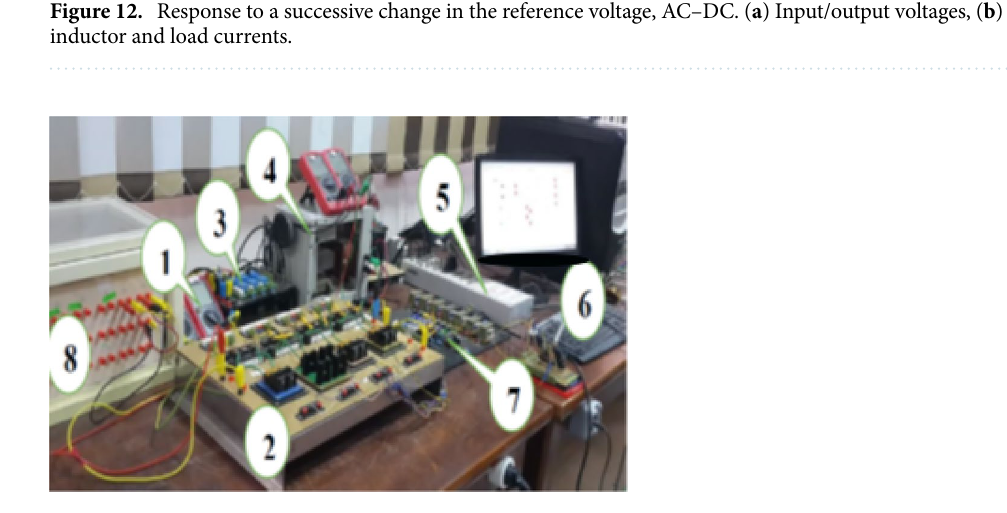
Figure 13. Experimental setup for the proposed